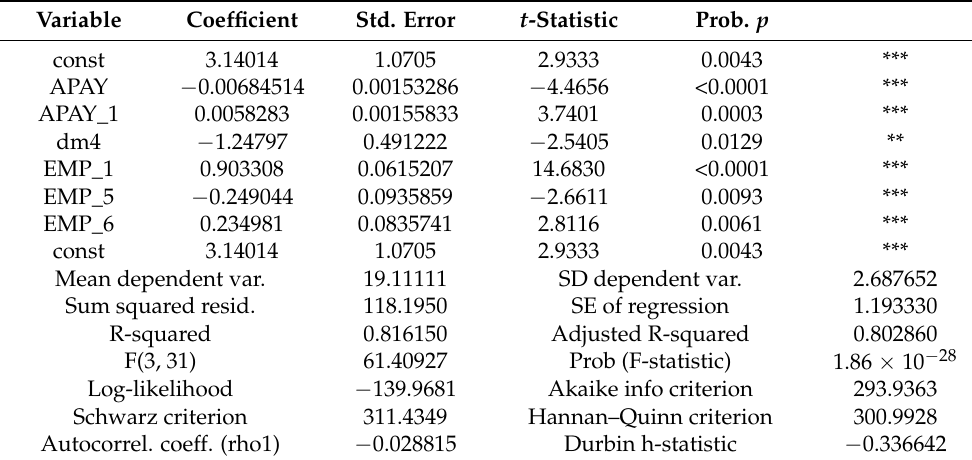
Table A1. Dependent variable: number of employees, in full-time equivalents, in period t (EMP) (observation 2000:07–2007:12 (N =